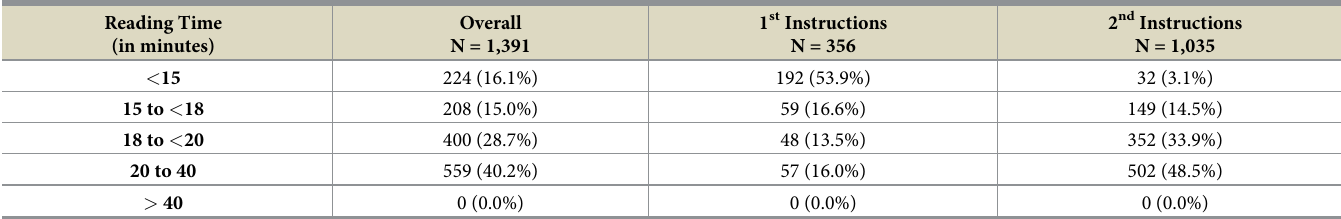
Table 4. Reading time self-test according 2 versions of instructions.